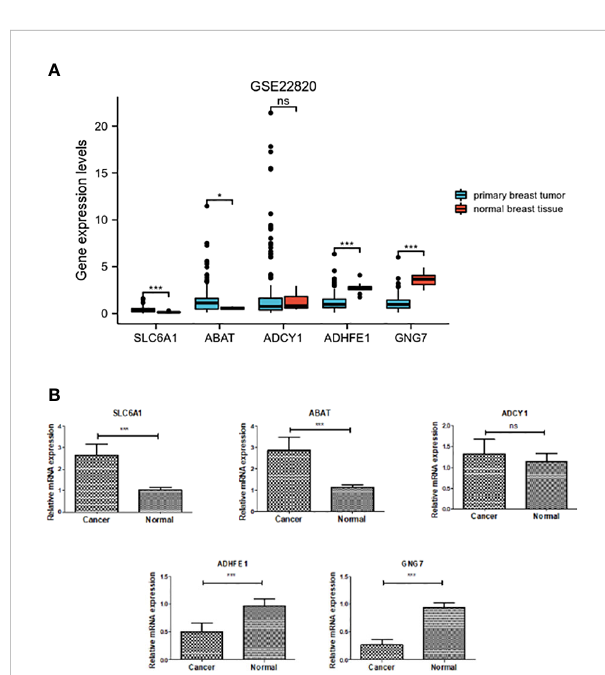
FIGURE 6 Veri fi cation of expression of the fi ve DEGRGs. (A) Gene expression level of fi ve DEGRGs in the GSE22820 dataset. (B) Gene expression level of fi ve DEGRGs in 8 pairs of breast cancer tissue samples. *p < 0.05, ***p < 0.001. "ns" is no signi fi cant